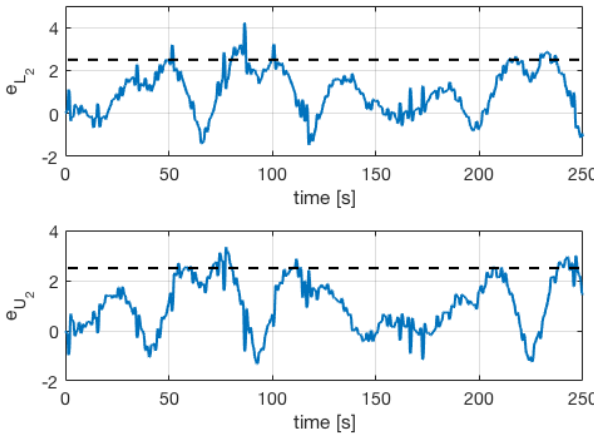
Figure 9. Fault F1 scenario under a random noise. Residual signal e U high air oil content, despite noise on the input signal.